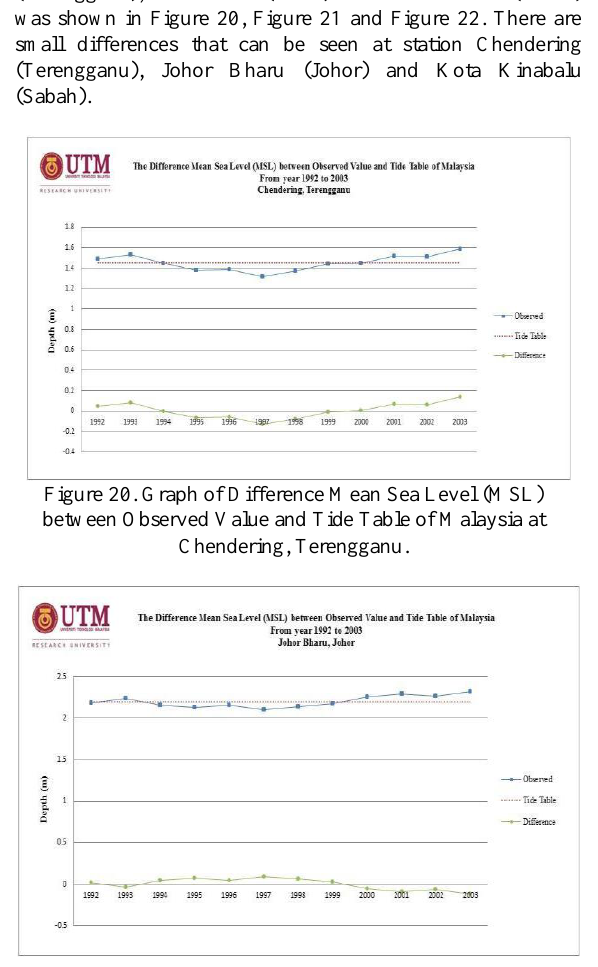
Figure 21. Graph of Difference Mean Sea Level (MSL) between Observed Value and Tide Table of Malaysia at Johor Bharu, Johor.